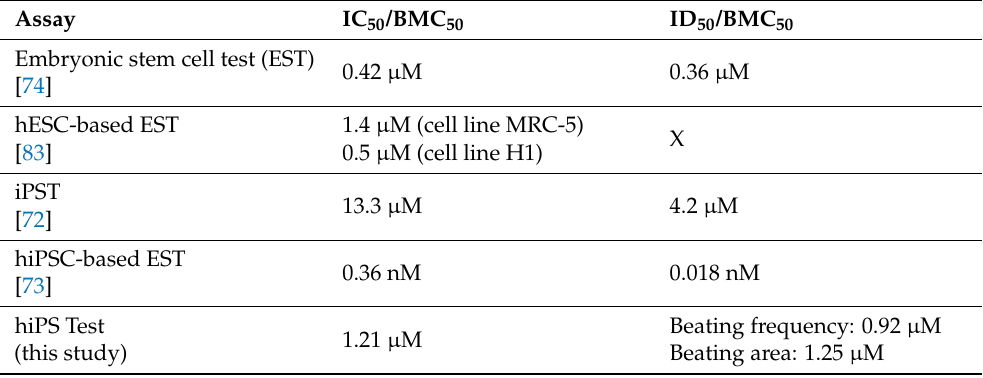
Table 1. Comparison of half-maximal inhibitory concentration of viability (IC 50 ), half-maximal inhibitory concentration of differentiation (ID 50 ), and benchmark concentration (BMC 50 ) values for 5-FU of in vitro embryotoxicity assays based on stem cell differentiation into